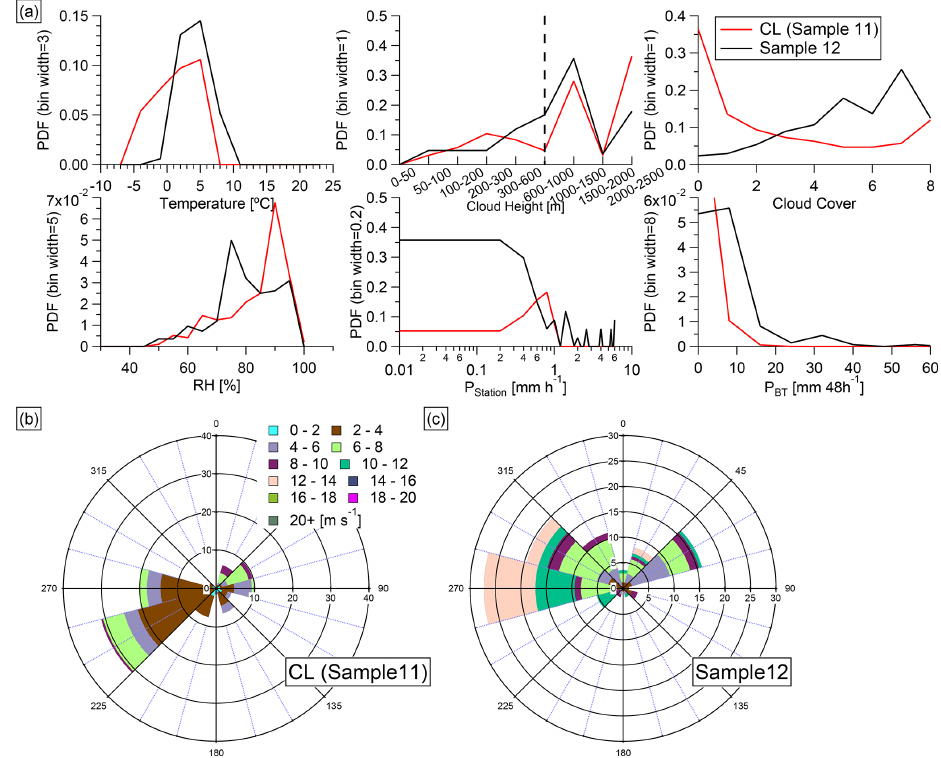
Figure 6. (a) Probability density function (PDF) of temperature, cloud height, cloud cover, relative humidity (RH), precipitation measured at the station ( P Station ), and cumulative precipitation along the backward trajectory in the past 2d ( P BT ) during samples 11 (red) and 12 (black). The dashed line in the cloud height panel shows the measurement station height. (b) The wind rose plot during sample 11. (c) The wind rose plot during sample